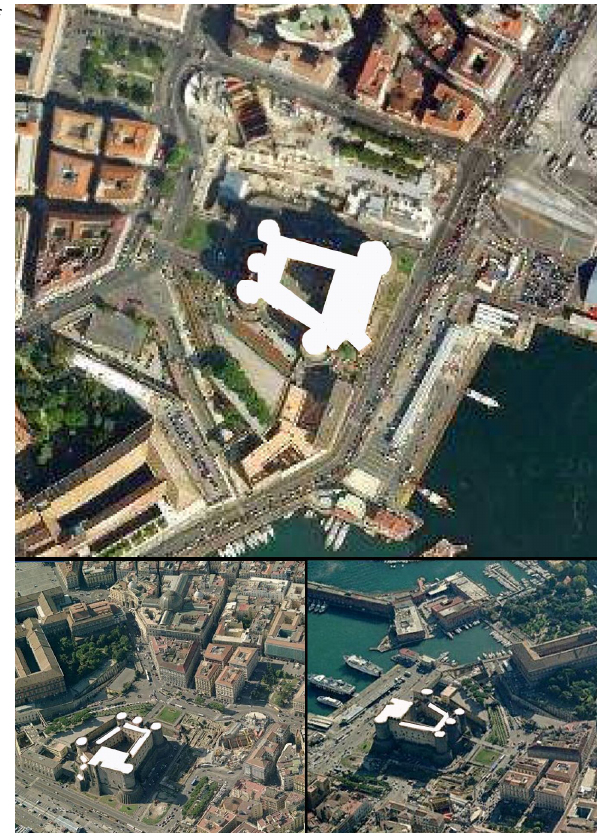
Figure 13: in our communication concept, the current image of the castle is used as a link between real and virtual environment.